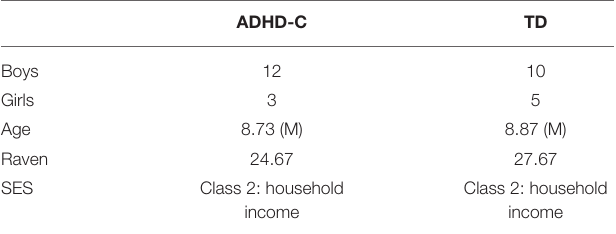
TABLE 1 | Descriptive statistics of the